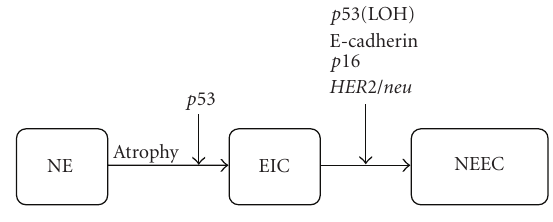
Figure 3: A progression model for nonendometrioid (type II) carcinomas. p53 mutations play a critical role in the conversion of atrophic endometrium to an intraepithelial form of serous carci- noma. NE, normal endometrium; EIC, endometrial intraepithelial carcinoma; NEEC, non-endometrioid endometrial